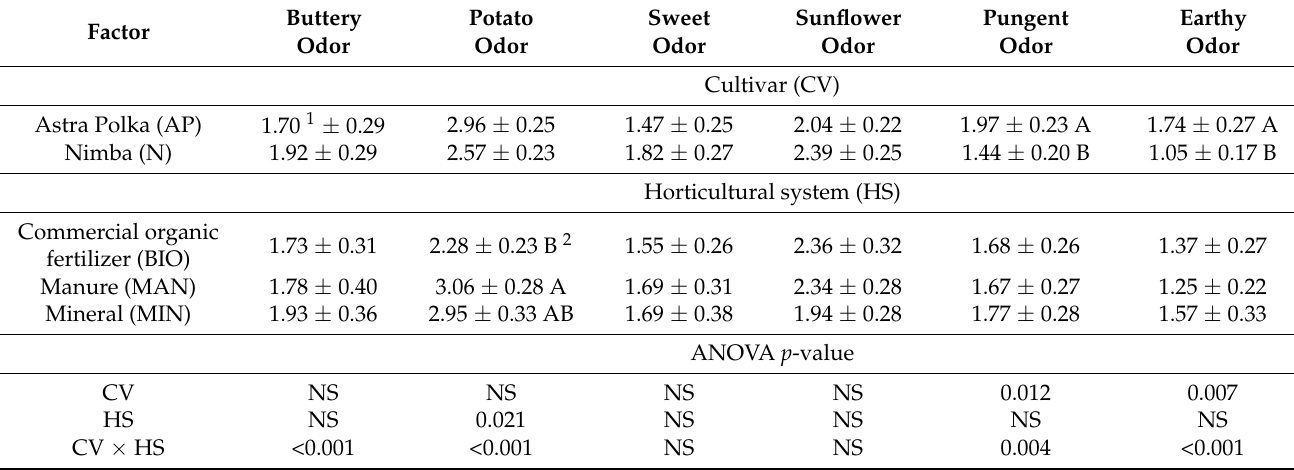
Table 6. The main effect of, and interactions between, cultivar and horticultural system on the odor attributes of cour- gette fruits.